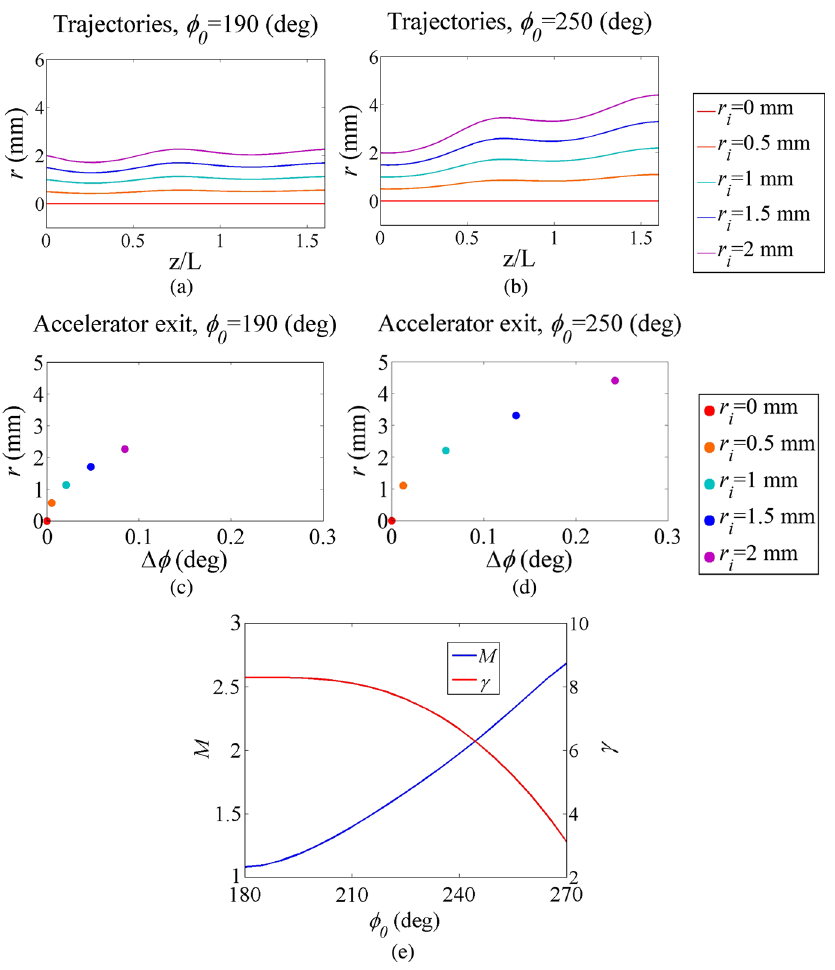
FIG. 3. Trajectories of electrons injected at ϕ 0 ¼ ð a Þ 190 ° and (b) 250° in an rf injector. Δ ϕ − r distributions of electrons with injection phase ϕ 0 ¼ ð c Þ 190 ° and (d) 250° at the accelerator exit. (e) Radial magnification factor M versus initial phase ϕ 0 (blue curve), and Lorentz factor γ versus ϕ 0 (red curve). The M − ϕ 0 and γ − ϕ 0 relationships indicate an increased radial magnification and a decreased energy gain for off-crest acceleration,